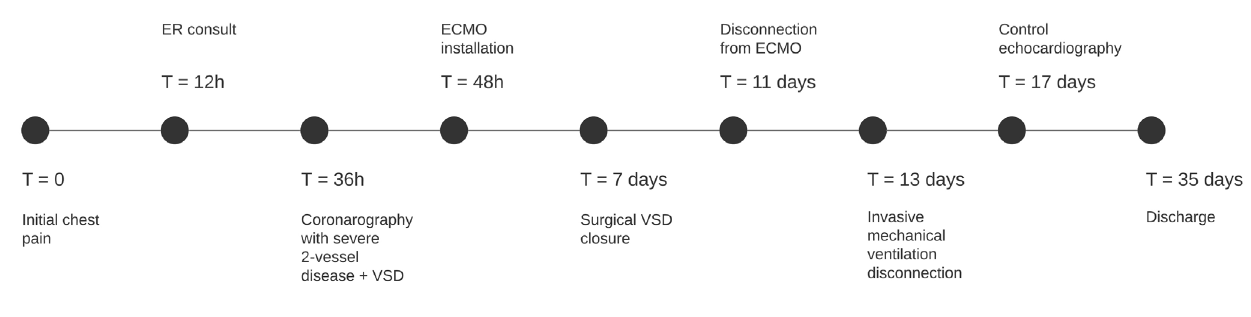
Fig. 3 - Summary timeline from the onset of patient’s chest pain until discharge. The time of main events and interventions is